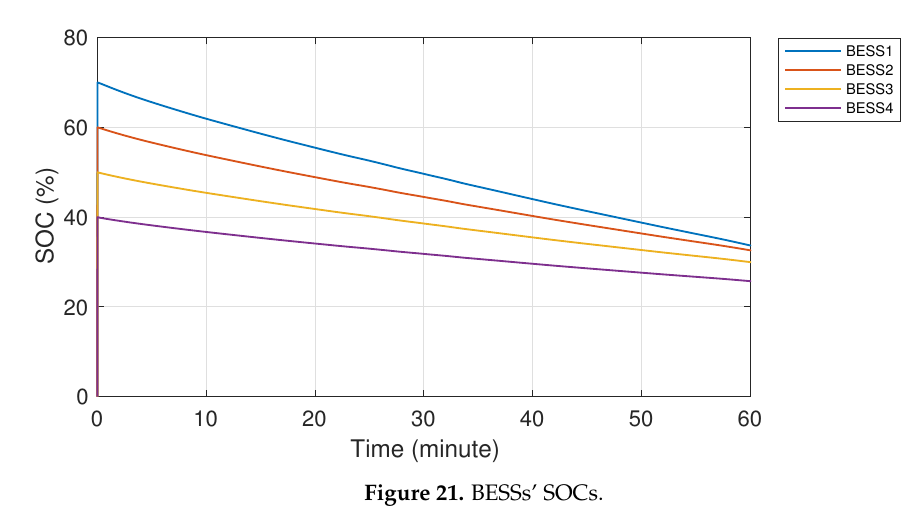
Figure 21. BESSs’